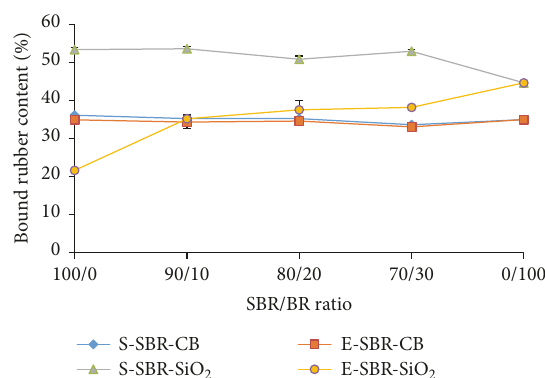
Figure 3: Bound rubber content (BRC) of the rubber